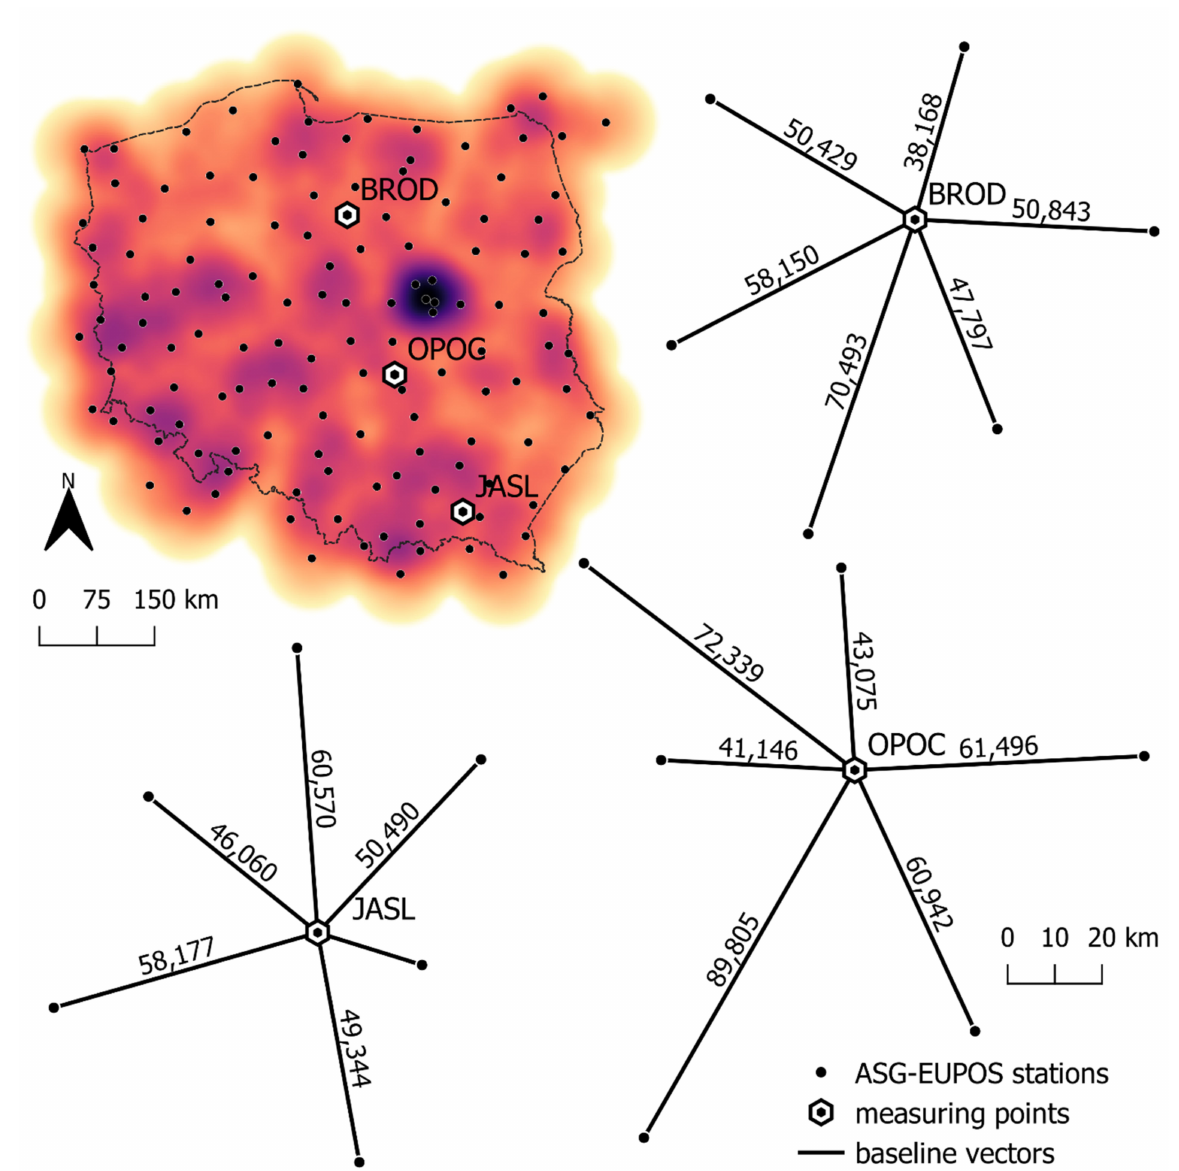
Figure 3. Location of research points in the ASG-EUPOS network, visualisation of network density using a kernel density estimator and a 75 km radius (the mean distance required for national EUPOS GNSS networks), and configuration of research points in relation to the six nearest reference stations in the